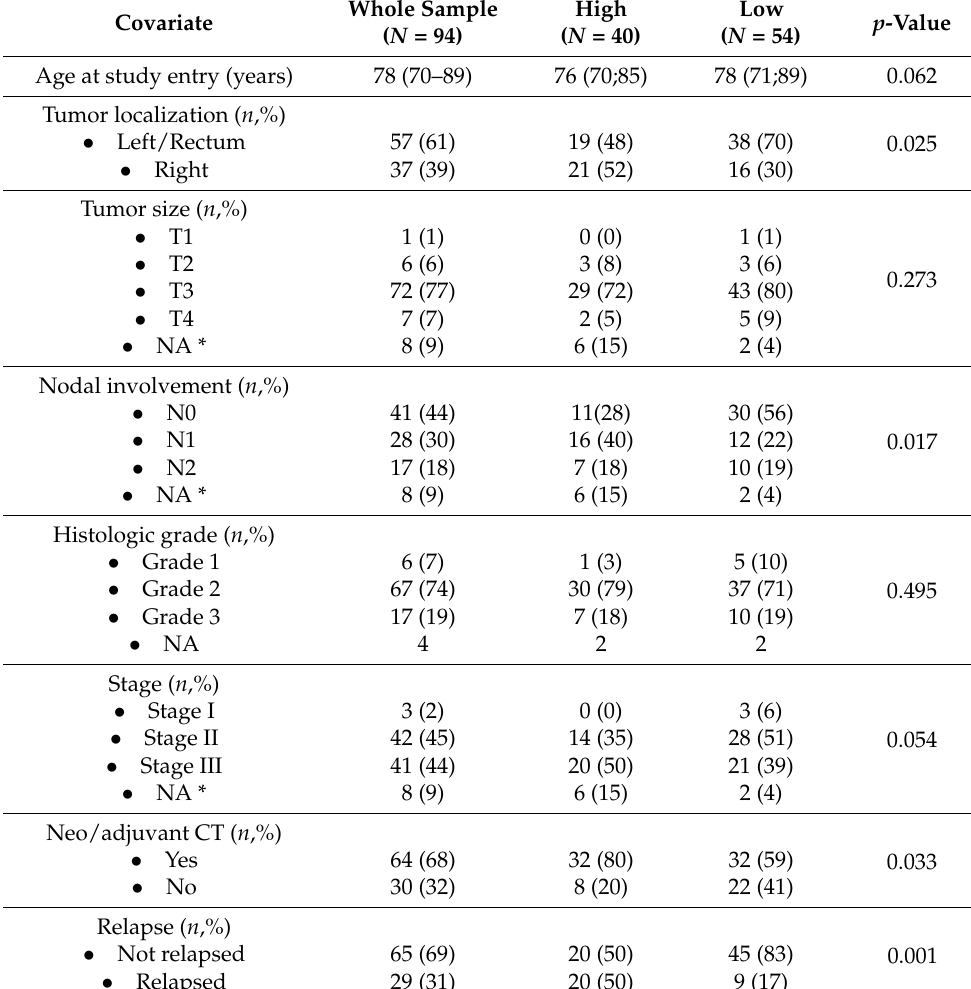
Table 3. Patient and disease characteristics by metabolomic risk (eCRC cohort). Whole Covariate